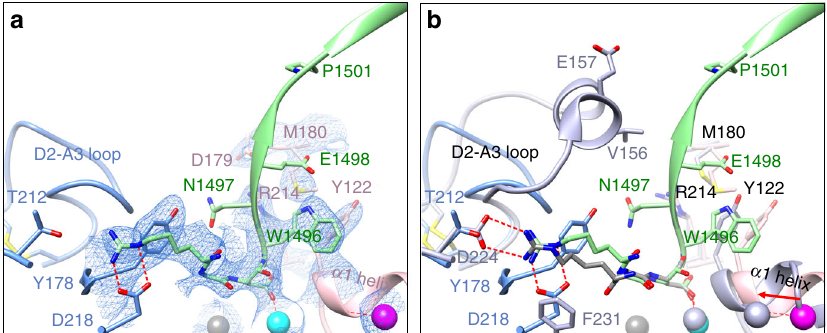
Fig. 3 Crystal structure of α V β 3/Hr10 complex. a Ribbon diagram of the crystal structure of α V β 3-bound Hr10 (same view as Fig. 1a) showing 2fo – fc map at 1.0 σ (blue mesh) of the ligand-binding region. Relevant portions of Hr10 (light green), α V propeller (light blue), and the β A domain of β 3 subunit (rose color) are shown. Side chains of amino acids (single letter code) are shown as sticks in the respective colors. The Mn 2 + ions at LIMBS, MIDAS, and ADMIDAS are in grey, cyan, and magenta spheres, respectively. Oxygen, nitrogen, and sulfur atoms are colored as in Fig. 1a. Water molecules are not shown. Hr10 ’ s W 1496 forms a π – π interaction with β A-Y 122 , and Hr10-Har 1493 forms a bidentate salt bridge with α V-D 218 . b Ribbon diagrams of the crystal structures of Hr10/ α V β 3 (light green) and epti fi batide/ α IIb β 3 (light purple, 2vdn.pdb) superposed on the β A domain of each. View, domain, side chain, and metal ion colors are as in a . Note the removal of the predicted clash of Hr10 with D2-A3 loop of α IIb and predicted formation of Hr10-Har 1493 / α IIb-D 224 salt